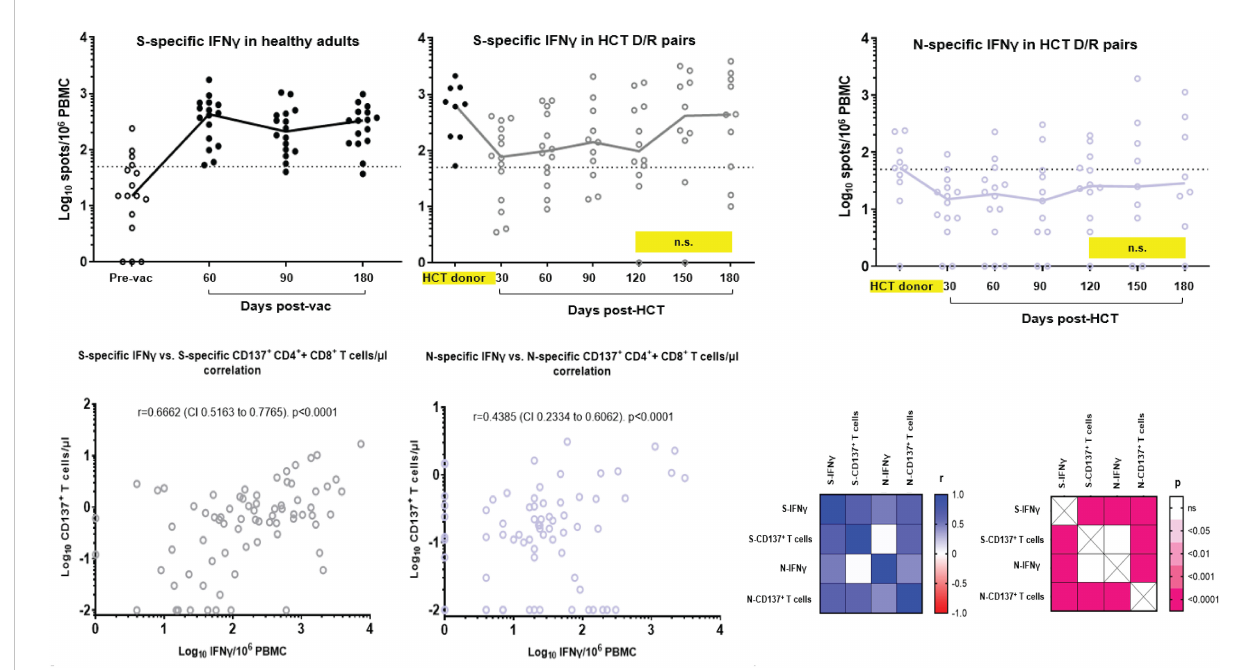
FIGURE 2 SARS-CoV-2-speci fi c IFN- g production and Th1 response correlative analyses. Upper panel, S-speci fi c IFN- g were measured by ELISPOT and expressed as spots/10 6 PBMC in: upper left plot , a reference cohort of healthy adults (COH IRB 20720 observational study of SARS-CoV-2 adaptive immunity after COVID-19 licensed vaccines) before (empty dots) and after BNT162b2 mRNA COVID-19 vaccine, at the days indicated on the x -axis ( fi lled black dots); middle left plot : HCT donor ( fi lled black dots, single blood draw as speci fi ed in Figure 1 legend) and recipient (grey empty dots) available PBMC specimens at the days post-HCT indicated on the x -axis. N-speci fi c IFN- g was measured by ELISPOT and expressed as spots/10 6 PBMC in available PBMC from HCT donor and recipient pairs (purple empty dots, upper right plot ). Black lines indicate median values; individual measurement trajectories are shown for each participant. In the upper middle and right plots, differences between HCT donor and recipient T-cell levels were signi fi cant ( p < 0.05, calculated by Mann – Whitney U test) unless otherwise indicated (n.s., not signi fi cant; yellow boxes). The dashed lines represent the arbitrary threshold for positive response (50 spots/10 6 PBMC). The total number of recipients analyzed for SARS-CoV-2-speci fi c IFN- g is N=14. R019 was not tested since the only PBMC vial obtained at each time point for this patient was used for the CD137 and memory phenotype assays (Figure 1). Bottom panel, Spearman ’ s correlation analysis between S-speci fi c IFN- g versus CD137 + T-cell (CD137 + CD3 + CD4 + + CD137 + CD3 + CD8 + ) levels (bottom left plot) and N-speci fi c IFN- g versus CD137 + T-cell (CD137 + CD3 + CD4 + + CD137 + CD3 + CD8 + ) levels (middle bottom plot). Spearman correlation coef fi cients and p values were calculated and plotted as a matrix (bottom right matrices). All available data obtained at all time points were used for the correlation analyses. Pre-vac, prevaccination; post-vac, post-vaccination; r , correlation coef fi cient; CI , con fi dence